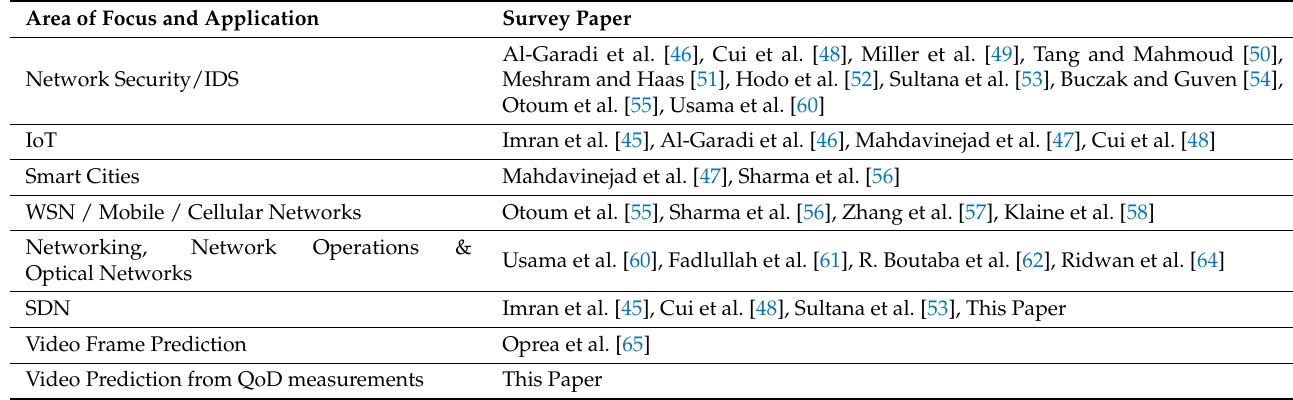
Figure 4. A summary of existing surveys and the branches of AI considered. Traditional ML algorithms dominate the literature, possibly owing to the lower computational requirements. A good number of studies combine DL and ML techniques. Table 1. Areas of focus and applications considered in related surveys. The majority of the surveys we see are on ML applications in the network security domain. The growth of video traffic necessitates a review of existing works; this paper fills this